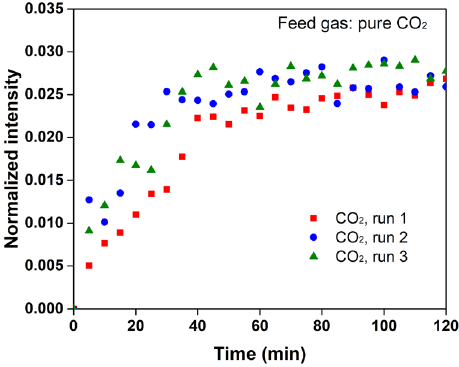
Figure 3. Growth of the normalized intensities of CO 2 in the hydrate phase with time. Runs 1–3 are repeated tests performed at the same experimental